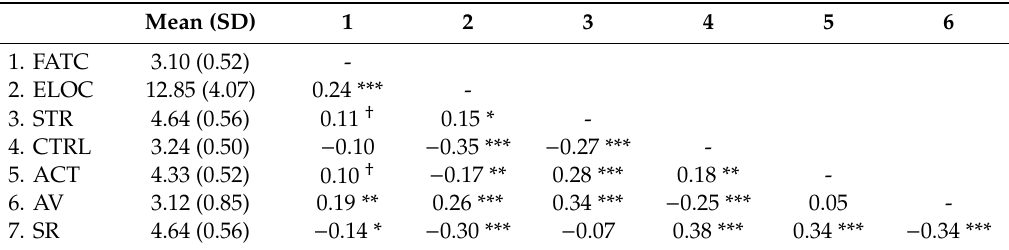
Table 2. Descriptive Statistics and Bivariate Correlations among the Measures in Study 2. Mean (SD)